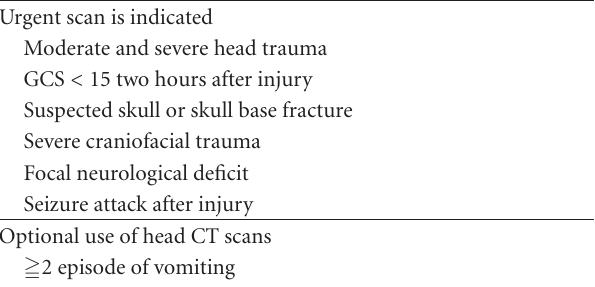
Table 1: Guidelines for emergent head CT scans for trauma pa- tients. The guideline is modified from “CT rules for mild brain injuries” advocated by the Taiwan Neurosurgical Society http://